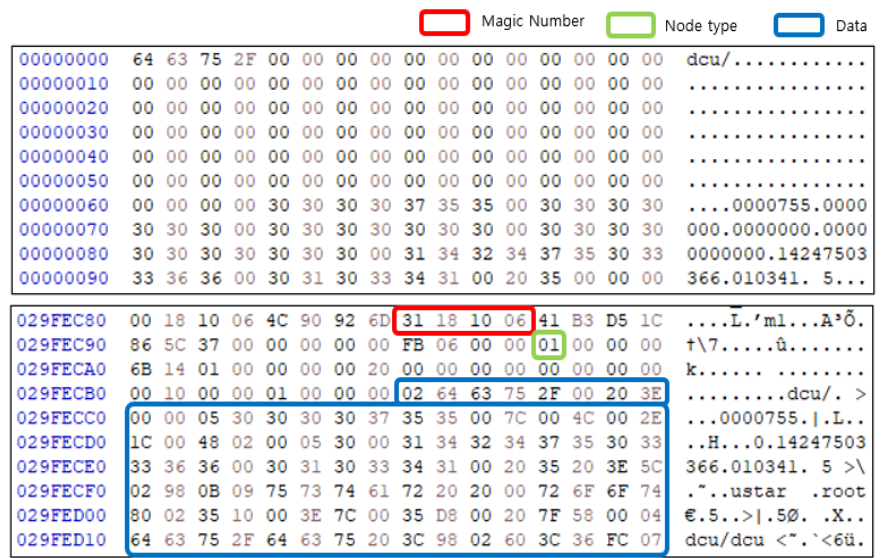
Figure 22. Actual file data in dcu.tar file(top)/data node which is dcu.tar file is stored (bottom).